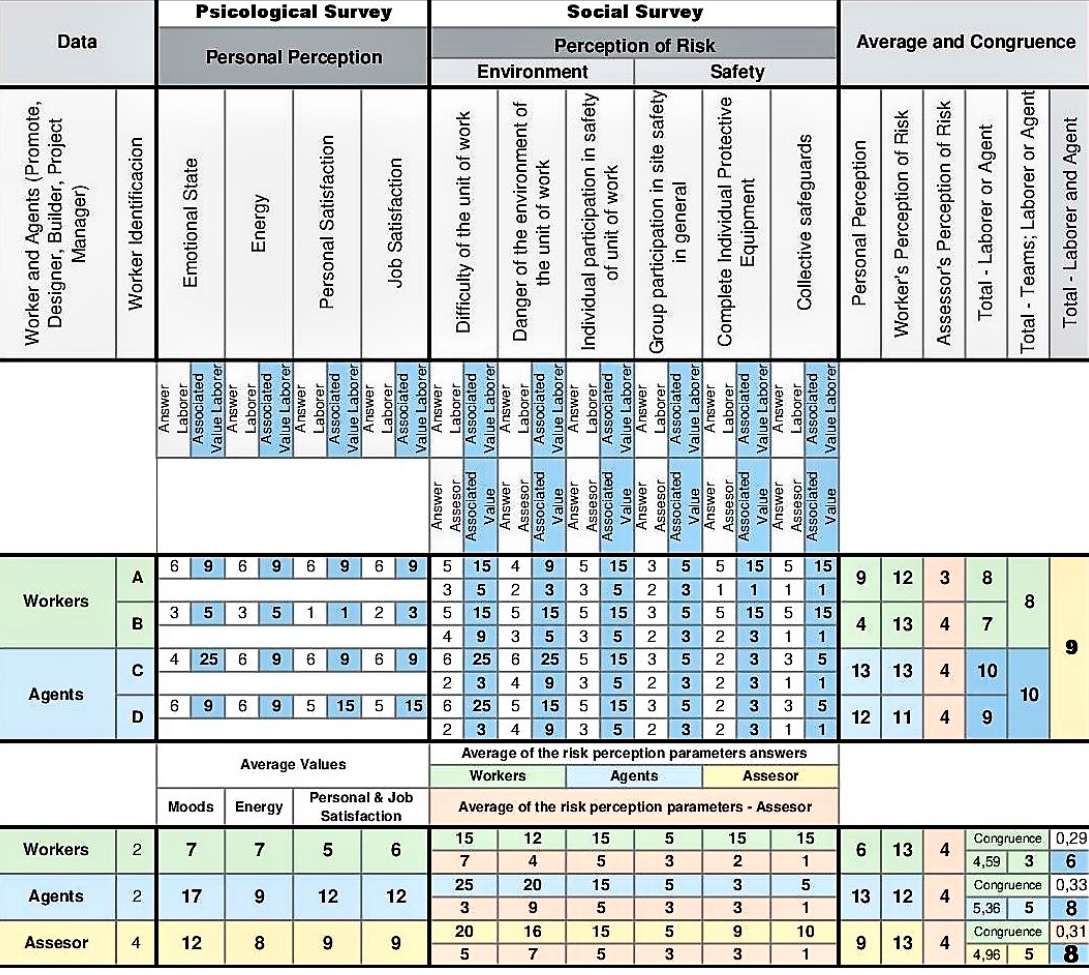
Figure A2. A simple psychosocial survey data collection.